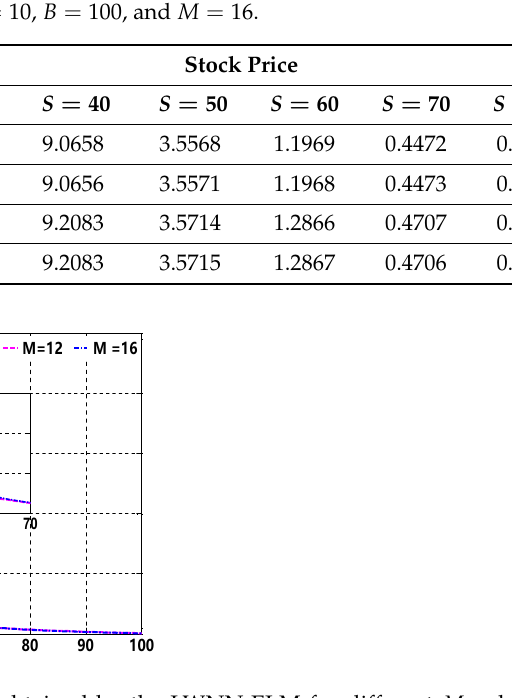
Figure 4. European put options price obtained by the LWNN-ELM for different M , where the corresponding parameters are α = 0.7, K = 50, T = 1, r = 0.01, σ = 0.1, A = 10, and B = 100. Table 4. The convergence order of the European put options price. N t is the number of discretization points regarding time; the number of discretization points regarding the stock price is fixed as N s =